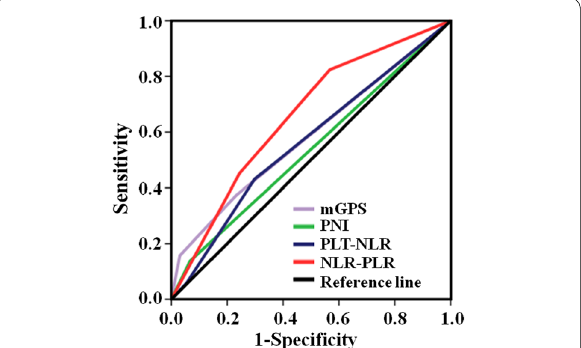
mGPS modified glasgow prognostic score, PNI prognostic nutritional index, PLT platelet count, NLR neutrophil-to-lymphocyte ratio, PLR platelet-to-lymphocyte ratio